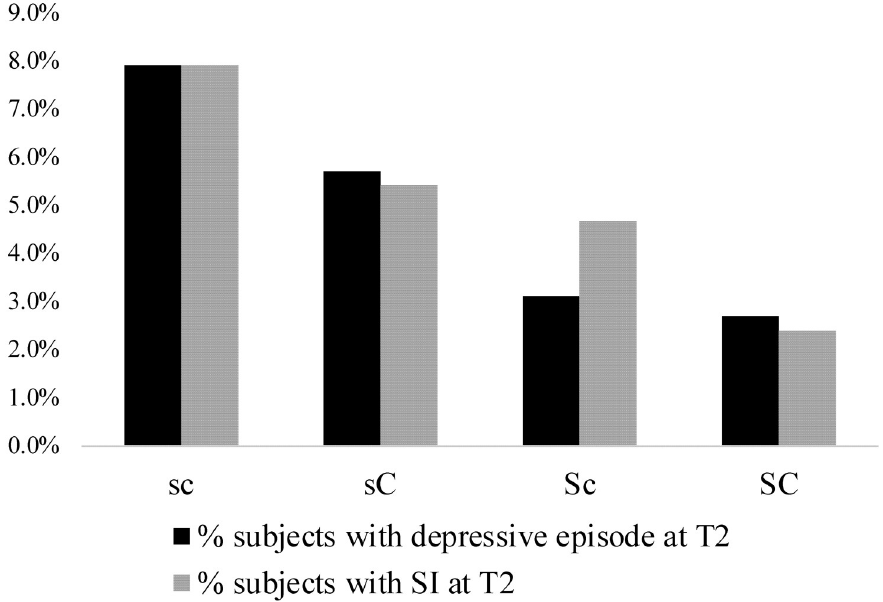
Fig 2. Cochran-Armitage trend test of four character configurations. Cochran-Armitage trend test: Depressive Episode, χ 2 trend = 20.7, p < 0.001, χ 2 liniarity = 0.87, p = 0.83; SI, χ 2 trend = 19.9, p < 0.001, χ 2 liniarity = 1.11, p = 0.77. C, cooperativeness score higher than median; c, cooperativeness score lower than median; S, self-directedness score higher than median; s, self-directedness score lower than median; SI, suicide-related ideation; T2, three years after enrolment.